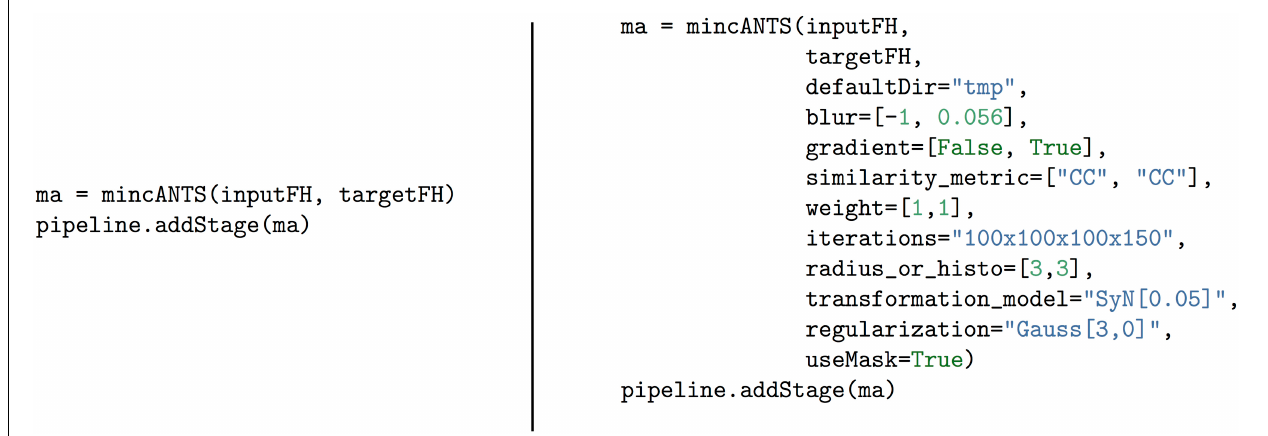
FIGURE 3 | Simplified call of the mincANTS atom (left) and a call that includes all arguments (right). The call on the left requires only an input and target file handler, and uses default arguments as mincANTS parameters. On the right is a mincANTS call that includes specific arguments as parameters,